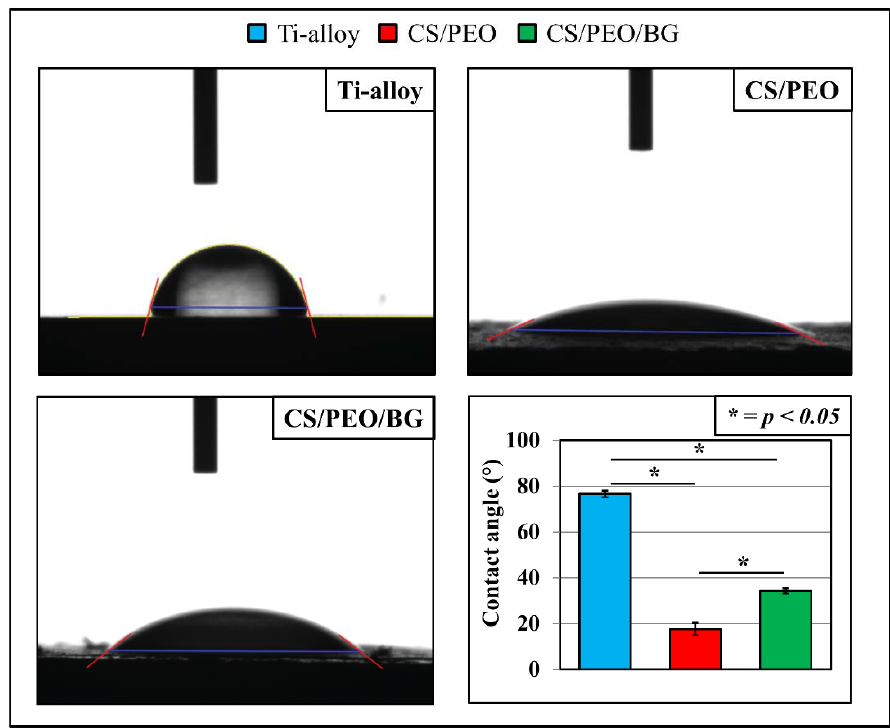
Figure 2. Water contact angle measurements on Ti-alloy and two Ti-alloy nanofiber-coated substrates (each sample labeled with a di ff erent color). Three substrates for each class were tested. CS: chitosan; BG: bioactive glass; PEO: polyethylene oxide.